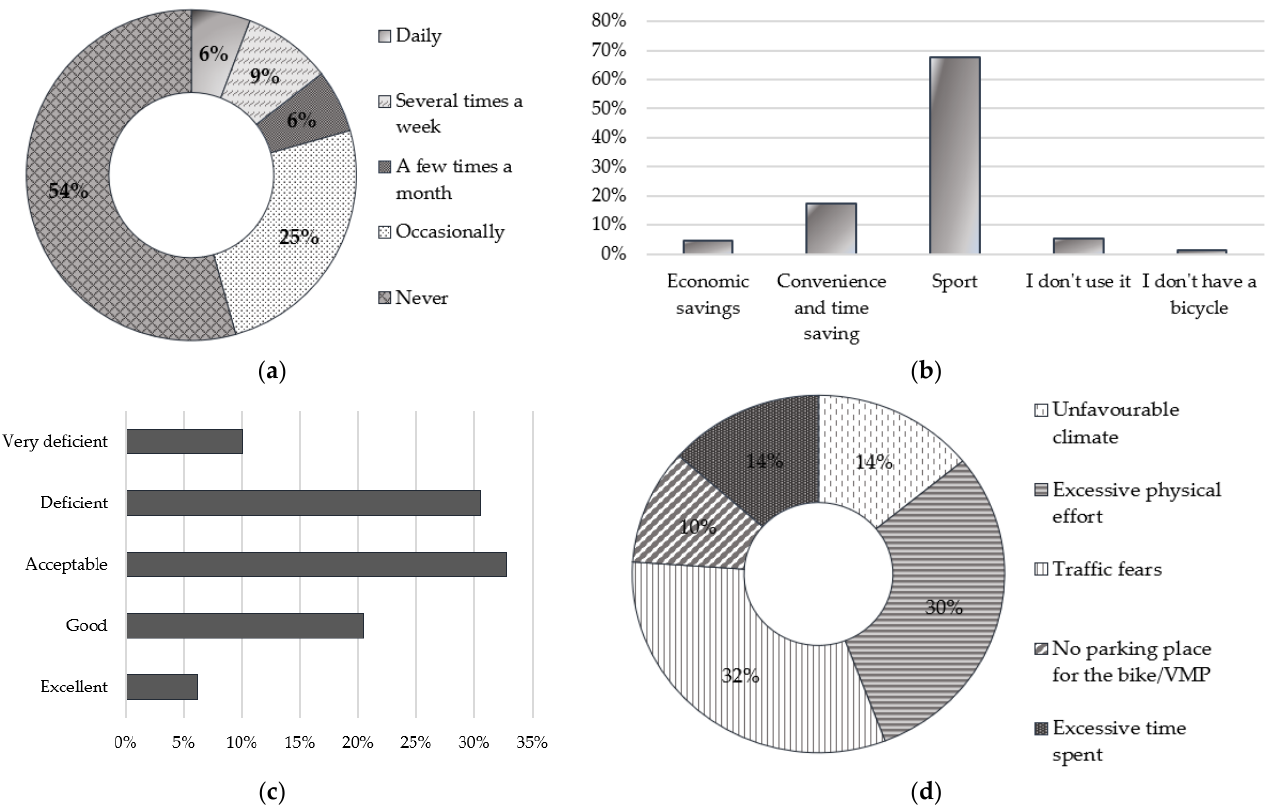
Figure 13. Cycling mobility situation in the RMSC. ( a ) Cycling frequency; ( b ) Reasons for cycling; ( c ) Cycling facilities; ( d ) Cycling difficulties.